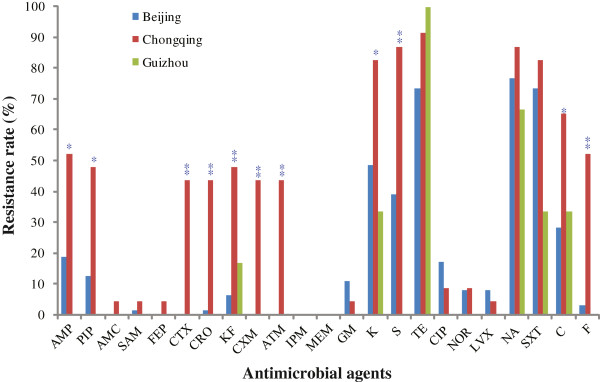
Antimicrobial resistance profiles of the STEC isolates. Three regions sampled are Beijing city (in blue), Chongqing city (in red), Guizhou province (in green). Statistical test was only performed between Chongqing and Beijing. A *and** were placed above the histogram for Chonqing samples if P < 0.05 and P < 0.001 respectively. Antibiotics abbreviations are: AMP, Ampicillin; PIP, Piperacillin; AMC, Amoxicillin-clavulanic acid; SAM, Ampicillin-sulbactam; FEP, Cefepime; CTX, Cefotaxime; CRO, Ceftriaxone; KF, Cephalothin; CXM, Cefuroxime; ATM, Aztreonam; IPM, Imipenem; MEM, Meropenem; GM, Gentamicin; K, Kanamycin; S, Streptomycin; TE, Tetracycline; CIP, Ciprofloxacin; NOR, Norfloxacin; LVX, Levofloxacin; NA, Nalidixic acid; SXT, Trimethoprim-sulfamethoxazole; C, Chloramphenicol; F, Nitrofurantoin.